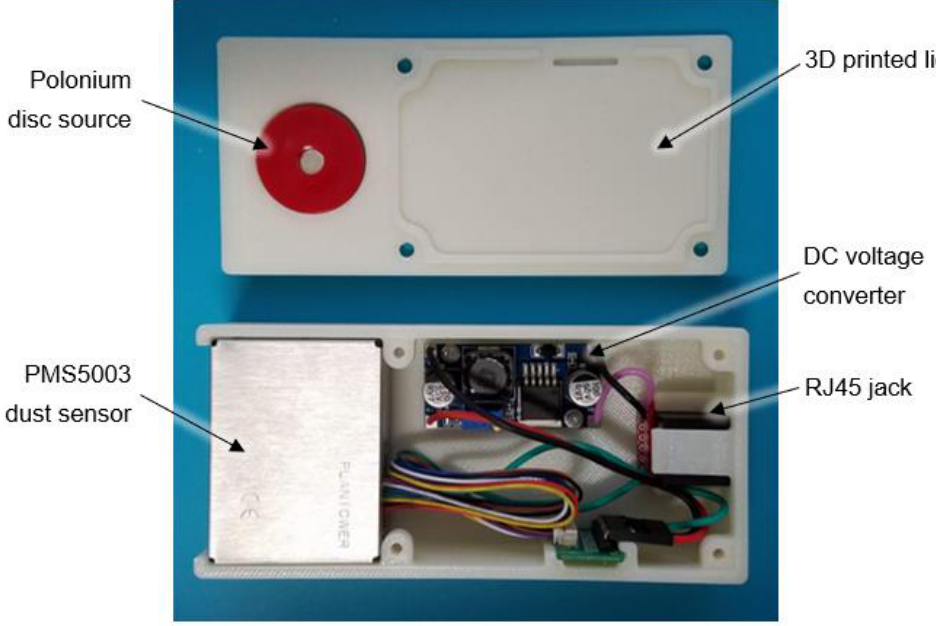
Figure 2. Inside view of 3D printed dust sensor enclosure showing components. Dust concentration data that were logged included PM1.0, PM2.5, and PM10 concen- trations ( µ g/m 3 ), and counts per unit volume for particle sizes of 0.3, 0.5, 1.0, 2.5, 5.0, and 10.0 microns (pcs/0.1 L). The indicated PM10 concentration from the PMS5003 sensor was used for dust generator